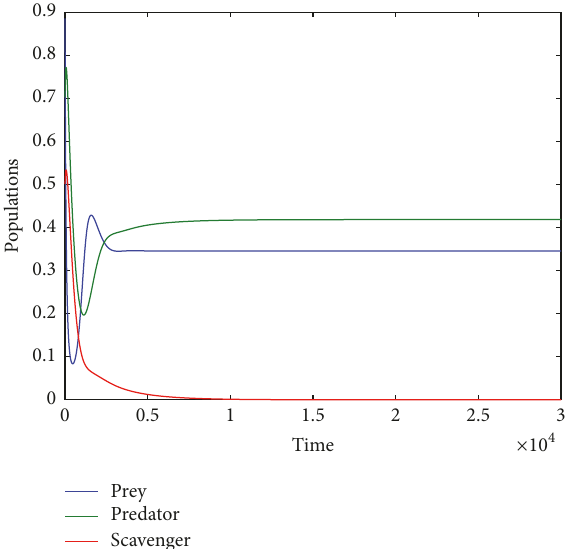
Figure 8: Time series for the solution of system (3) using data (76) with 𝜁 = 0.2 . The system approaches 𝐸 2 = (0.34,0.42, 0)